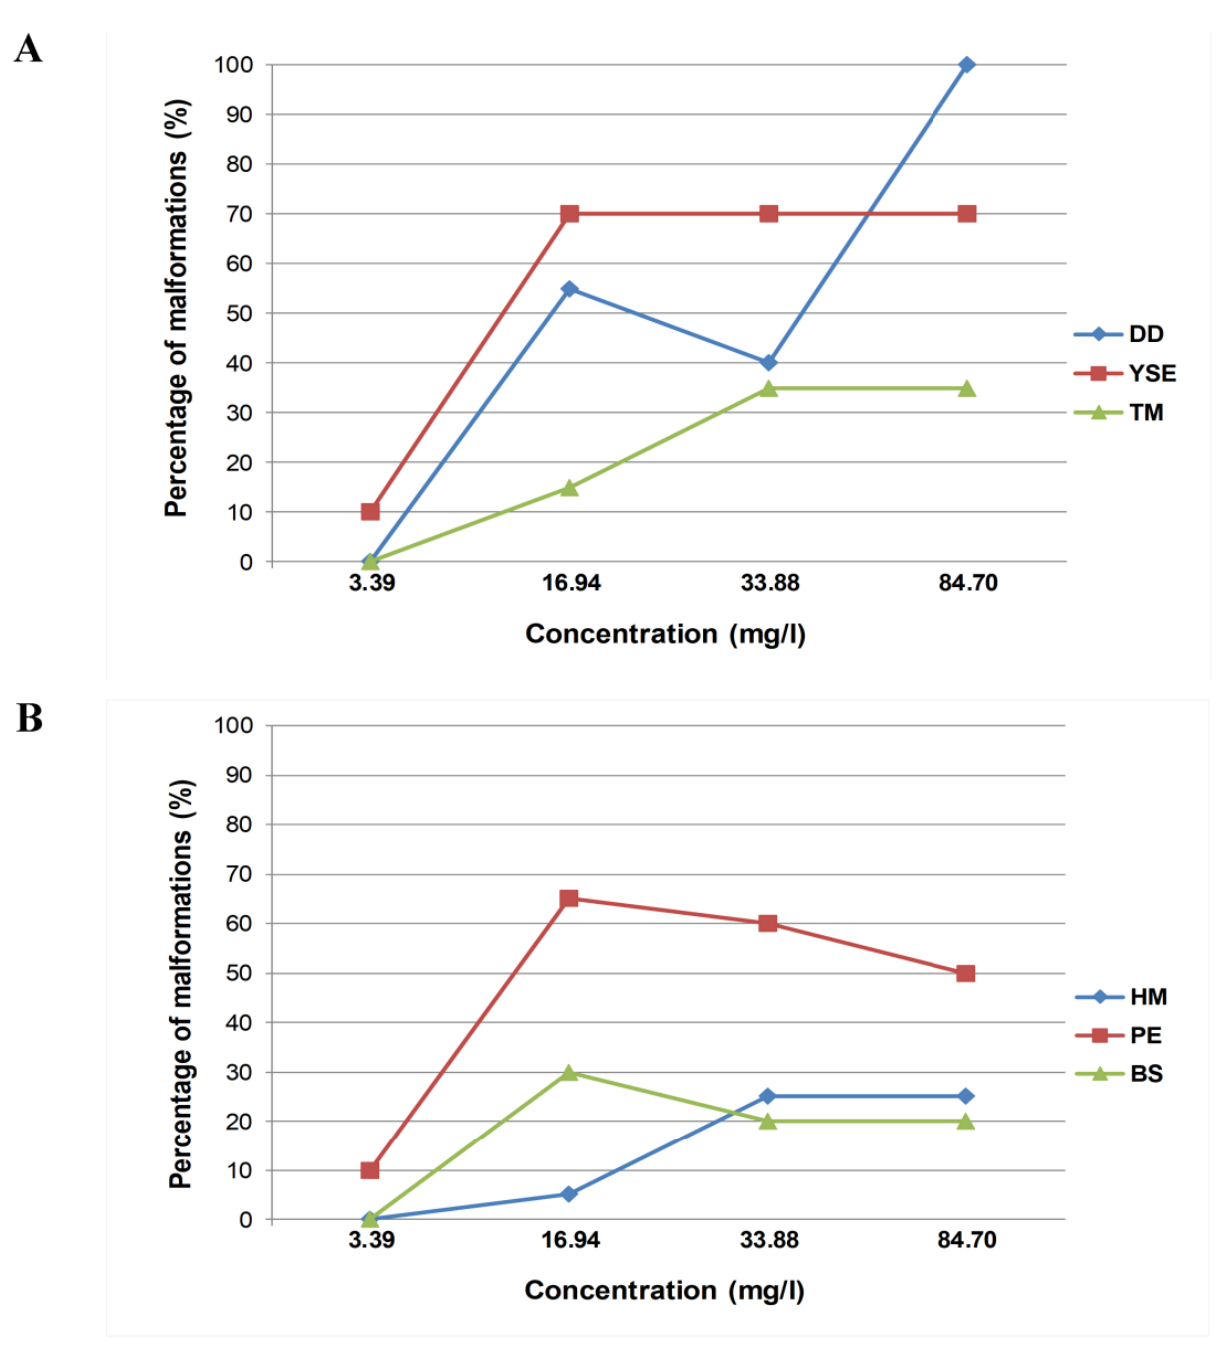
Figure 1. The percentage of developmental malformations in 96 hpf zebrafish larvae (wild-type AB strain) exposed to different concentrations of N -[(3-chloro-4-methoxyphenyl)methylidene]-4-methylbenzenesulphonohydrazide. Concentrations: 3.39 mg/L = 10 µ M; 16.94 mg/L = 50 µ M; 33.88 mg/L = 100 µ M; 84.70 mg/L = 250 µ M. ( A ): Malformations: DD–developmental delay, YSE—yolk sac edema, TM—tail malformation. ( B ): Malformations: HM–head malformation, PE— pericardium edema, BS–bent